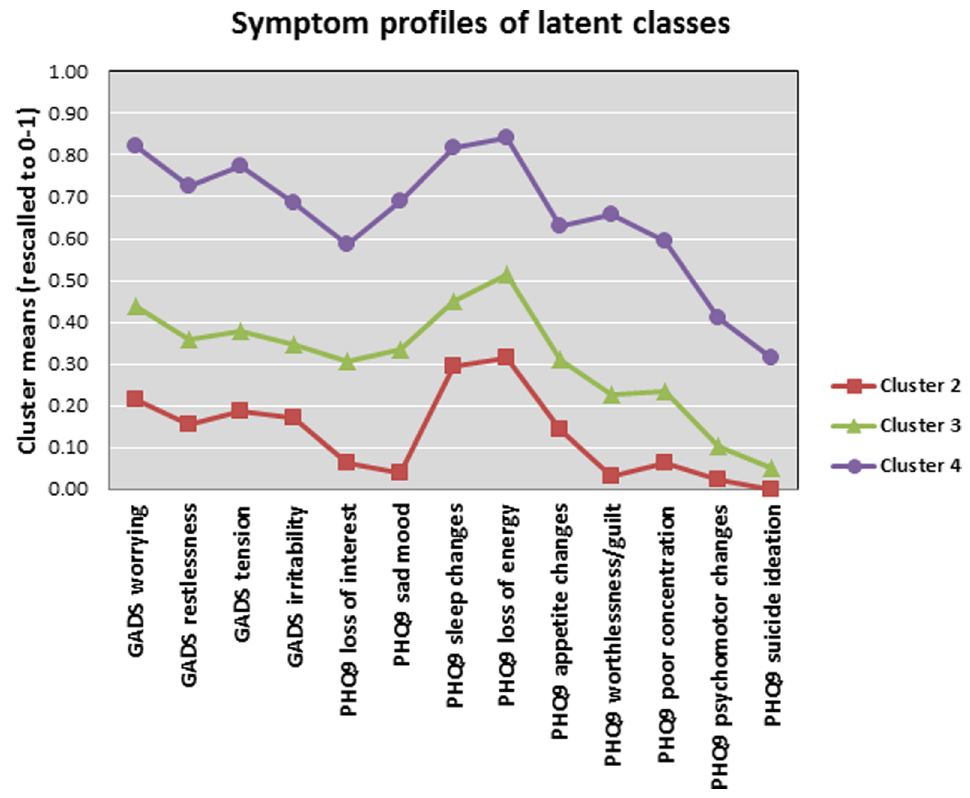
Figure 1. Symptom profile of the 4 (ordered) latent class model graph showing partial conditional probabilities for the 4-class model (LCA response profiles).